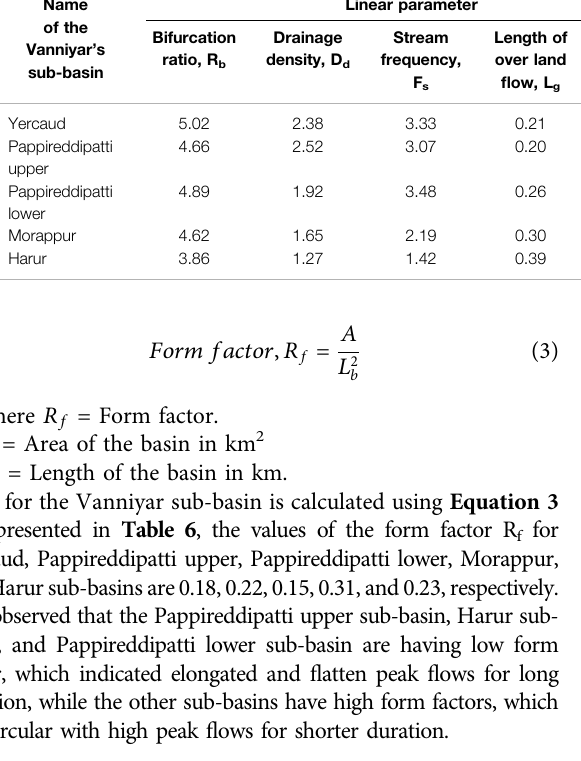
TABLE 6 | Analyzed morphometric parameters of the Vanniyar ’ s sub-basin, Dharmapuri district, Tamil Nadu, India. S.No Name of